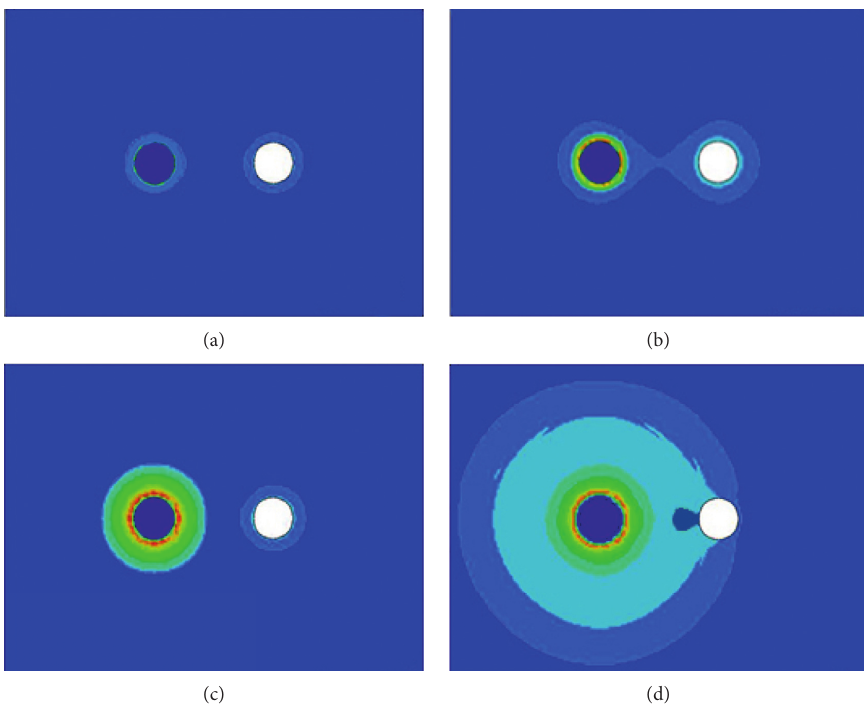
Figure 3: Cloud chart of dynamic stress distribution for implicit-explicit solution. (a) t � 0 μ s, (b) t � 90 μ s, (c) t � 180 μ s, and (d) t � 270 μ